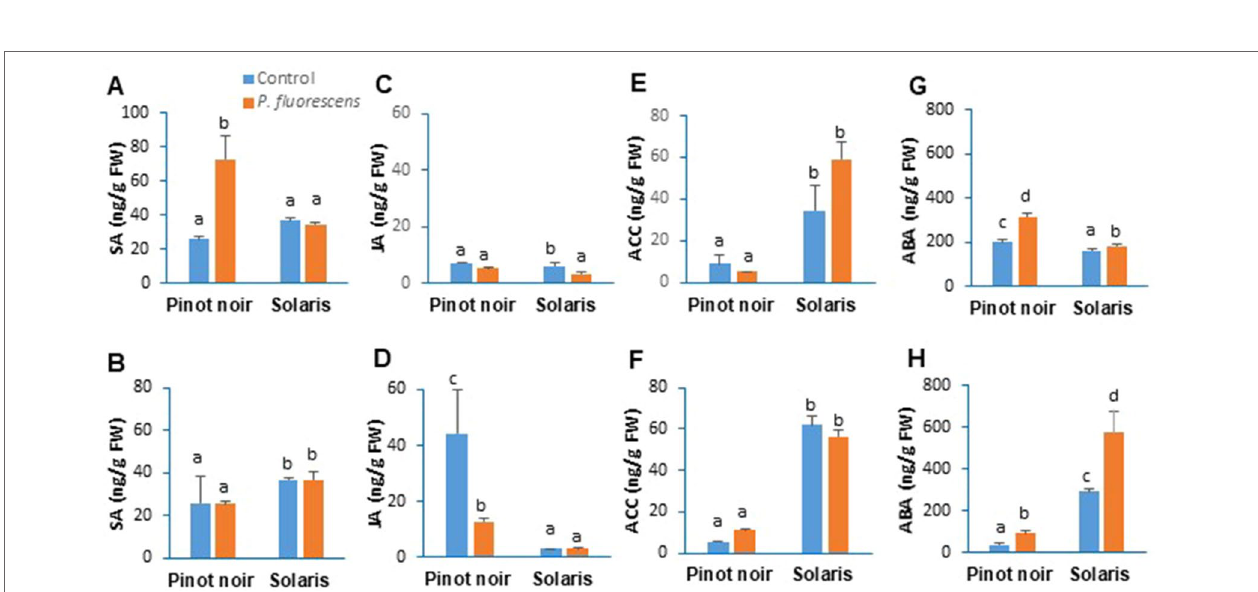
FIGURE 8 | Pseudomonas fluorescens PTA-CT2 primes phytohormone production in leaf disks of Pinot noir and Solaris after Plasmopara viticola and Botrytis cinerea inoculation. Grafted plants were treated with P. fluorescens PTA-CT2 at the root level. Two weeks later, leaf disks were excised from control and treated plants and infected with 20 µl of 10 5 spores per milliliter of P. viticola (A, C, E, G) or 5 µl of 10 6 conidia per milliliter of B. cinerea (B, D, F, H) . The amounts of salicylic acid (A, B) , jasmonic acid (C, D) , 1-aminocyclopropane-1-carboxylic acid (E, F) , and abscisic acid (G, H) were determined by liquid chromatography (LC)–tandem mass spectrometry (MS/MS) at 2 days post inoculation. Values corresponding to uninfected control or PTA-CT2-treated plants are similar to those before inoculation ( Figure 2 ). Data are the means from three independent experiments performed in 2017, and vertical bars indicate standard deviation. Different letters indicate statistically significant differences between the treatments (ANOVA Tukey test, P <